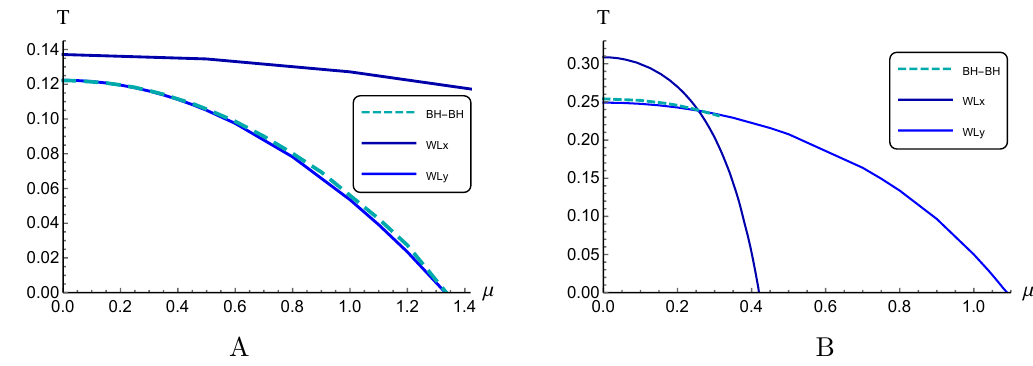
Figure 21 . Holographic QCD phase diagrams for light quarks (A) and for heavy quarks (B) in the anisotropic case [38]. Here Hawking-Page-like phase transitions (BH-BH) are indicated by dashed lines. Wilson loop phase transitions for different orientations (WLx and WLy) are shown by solid